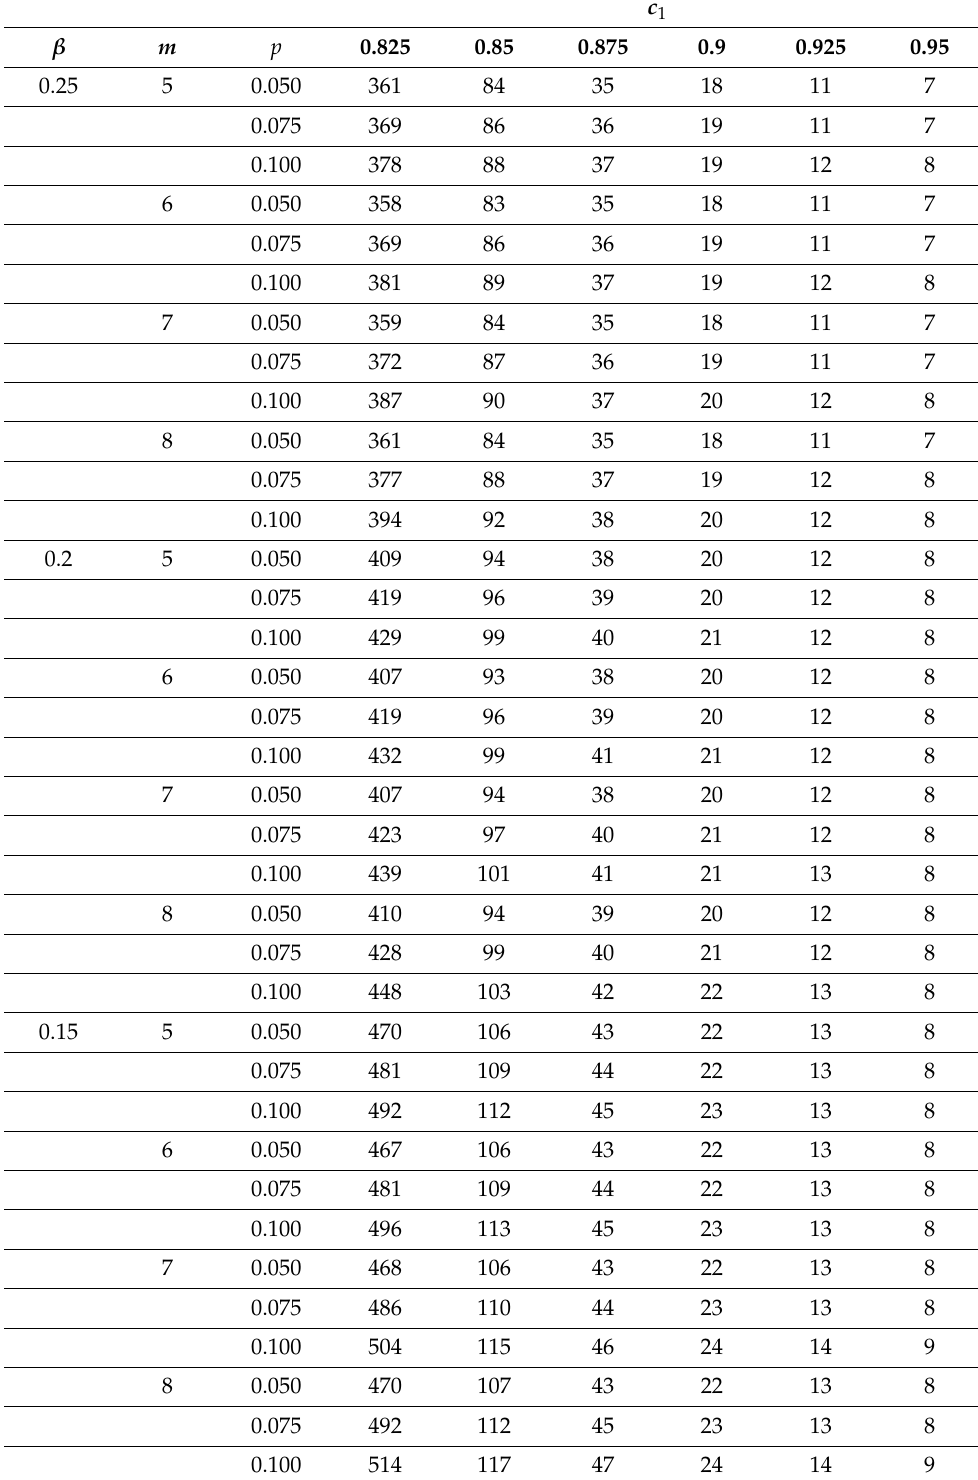
Table 2. The minimum sample size for c 1 = 0.825(0.025)0.9, m = 5(1)8 and p = 0.05(0.025)0.1 under α = 0.05, L = 0.05, T = 0.5, and c 0 =